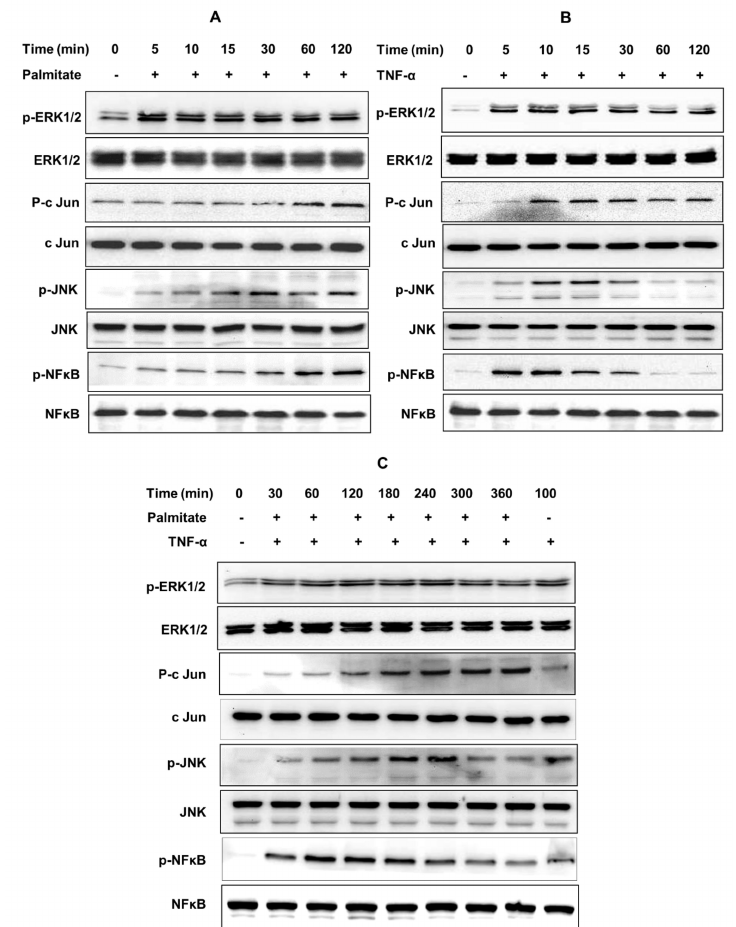
Figure 6. TNF- α / palmitate cooperativeness for CCL4 expression implicates ERK-1 / 2, c-Jun, JNK and NF- κ B phosphorylation. To further verify the involvement of MAPK / NF- κ B signaling pathways, phosphorylation of the transcription factors including ERK-1 / 2, c-Jun, JNK and NF- κ B was assessed by western blotting as described in the materials and methods section. The blots show the extended phosphorylation timings for ERK1 / 2, c-Jun, JNK and NF- κ B signaling proteins in cells that were co-stimulated with TNF- α / palmitate as compared to timings of respective phosphorylated proteins in cells that were treated with either palmitate or TNF- α . ( A ) Palmitate treatment induced phosphorylation of ERK1 / 2, c-Jun, JNK and NF- κ B for up to 120 min each. ( B ) TNF- α treatment induced phosphorylation of ERK1 / 2 and c-Jun, each for up to 120 min, phosphorylation of JNK for up to 15 min and phosphorylation of NF- κ B for up to 10 min. ( C ) TNF- α / palmitate co-stimulation induced phosphorylation of these signaling proteins for extended time periods, i.e., phosphorylation of both ERK1 / 2 and c-Jun for up to 360 min, phosphorylation of JNK for up to 240 min and phosphorylation of NF- κ B for up to 180 min. Note: Phospho- and total- ERK1 / 2: 42, 44 KDa; Phospho- and total- c-Jun: 48 KDa; Phospho- and total- JNK: 46, 54 KDa; and Phospho- and total- NF- κ B: 65